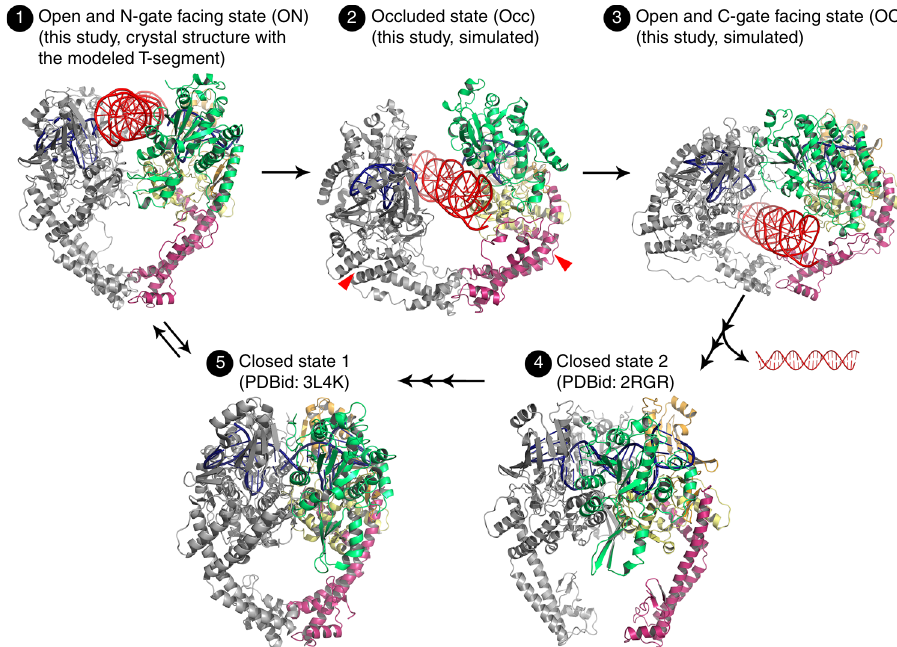
Fig. 5 The DNA-gate may undergo a “ rocker-switch ” -type movement during T-segment passage. Starting from the newly determined structure, referred to as the open and N-gate-facing state (ON state, step 1), the full process of T-segment passage through the DNA-gate can be simulated by steered MD calculations. In the absence of a T-segment, we speculate that the DNA-gate would switch between the closed state (step 5) and ON state (step 1, a conformation ready for the T-segment to enter). In the presence of a T-segment and a force that drives the T-segment toward the C-gate, the DNA-gate would transform to an apparently occluded state (Occ state, step 2) and then an open and C-gate-facing state (OC state). Although subsequent structural transitions were not explored in our simulation, a post-strand passage conformation with an intact G-segment and opened C-gate 8 suggests that once the OC state is reached, the C-gate will open to allow the release of the T-segment and the DNA-gate will resume the closed conformation to reseal